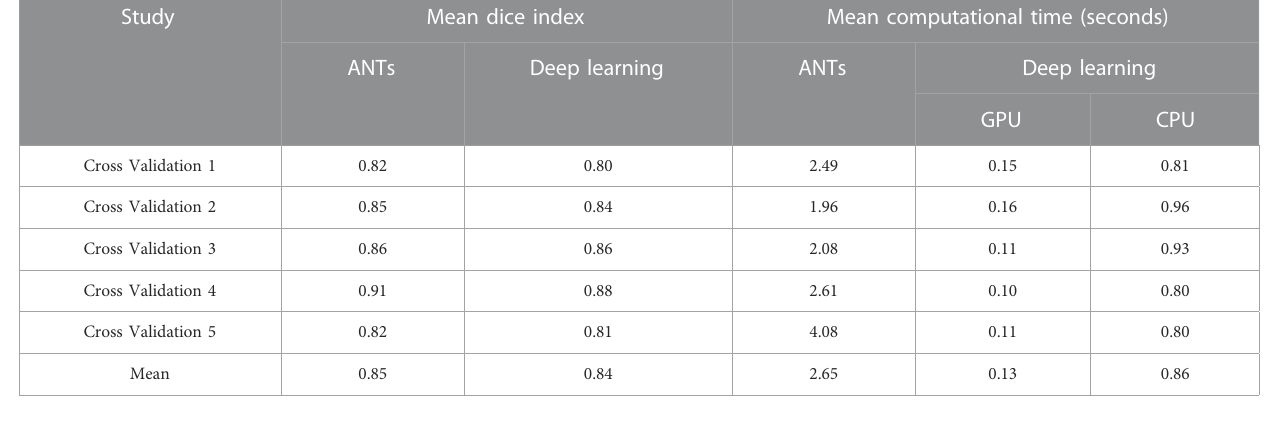
TABLE 1 Comparison of performance in image registration.